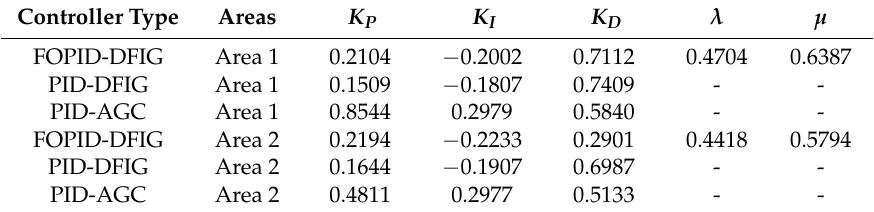
Table 2. Optimal parameters of controllers obtained by the sine-cosine algorithm